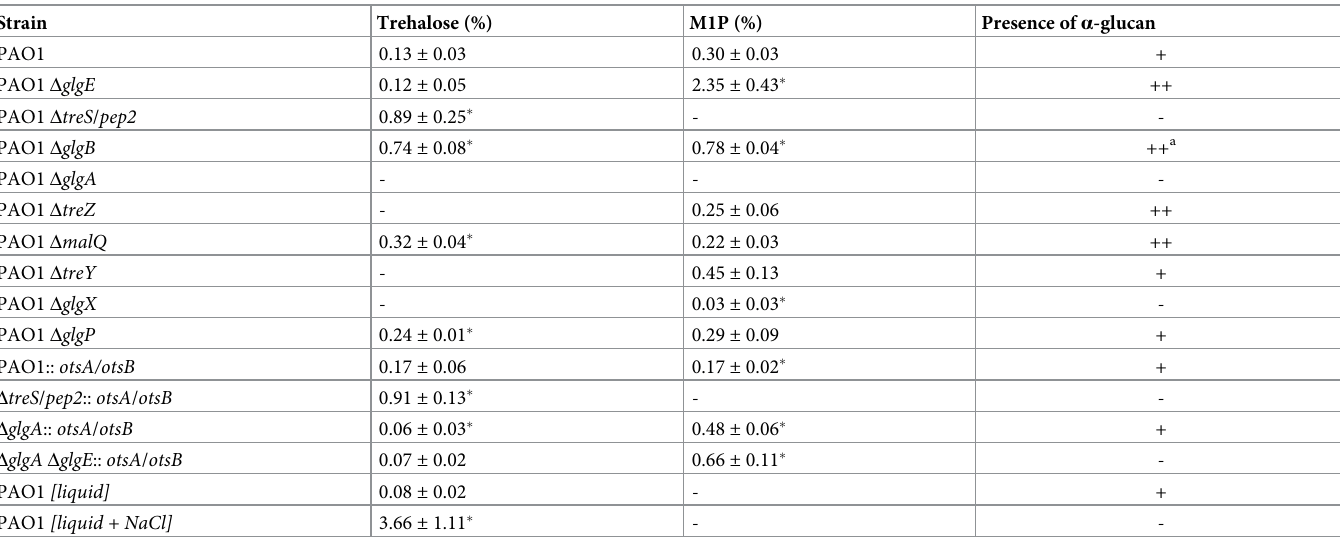
Table 2. Accumulation of trehalose and M1P in PAO1 strains.